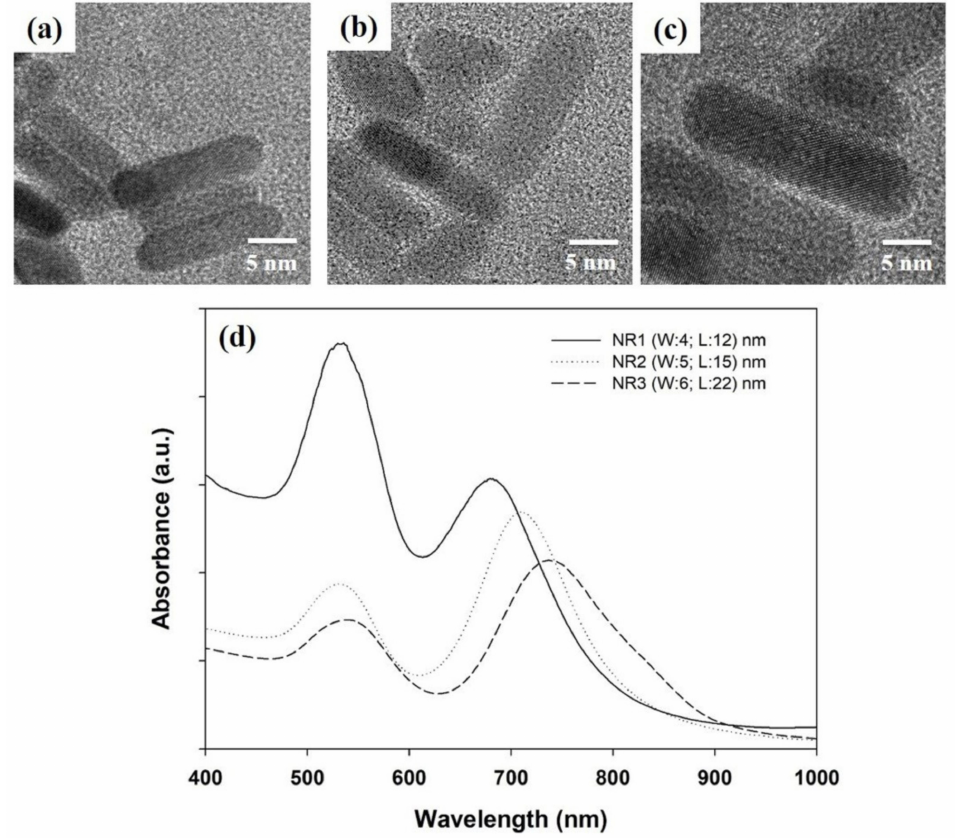
Figure 2. ( a – c ) Morphology of Au nanorods with different of size measured by transmission electron scope (TEM), ( d ) its UV-vis